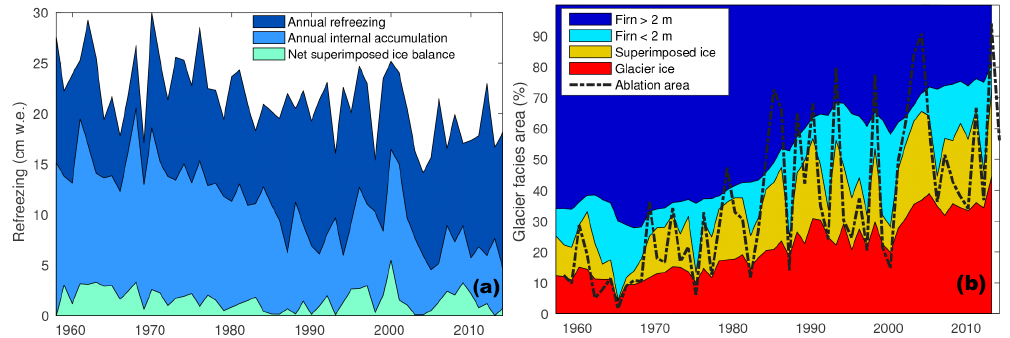
Figure 10. (a) Annual refreezing and internal accumulation (i.e. refreezing below the previous summer surface) and the net superimposed ice balance, i.e. the amount of superimposed ice at the end of each mass balance year. (b) Annual fractional areal extent of glacier facies divided into glacier ice, superimposed ice, thin firn ( < 2m) and thick firn ( > 2m). Table 7. Climatic mass balances derived from ice cores ( B clim ) (cmw . e . yr − 1 ) from Pinglot et al. (1999, 2001) and error (cid:15) (mod- eled − measured) for the three time periods. Z is elevation of the ice core and Z (cid:15) is elevation of the closest DEM grid cell minus ice core elevation. The year of ice core retrieval depends on the site and is denoted by 199X; see Pinglot et al. (1999, 2001) for exact years. The error is positive if modelled balance is larger than